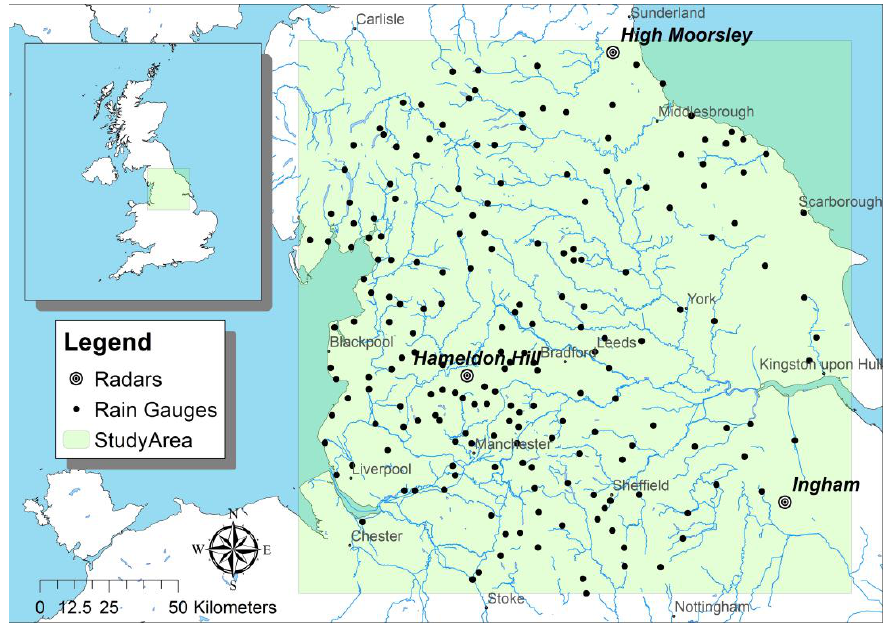
Figure 1. The UK study area is presented, including the Environment Agency (EA) rain gauges and the three radars available in the area.